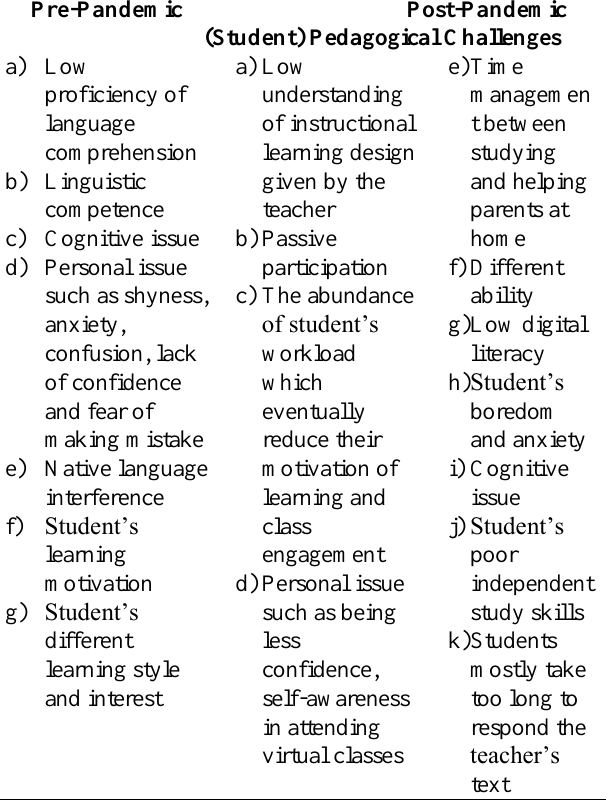
TABLE 8 | (Student) Pedagogical Challenges